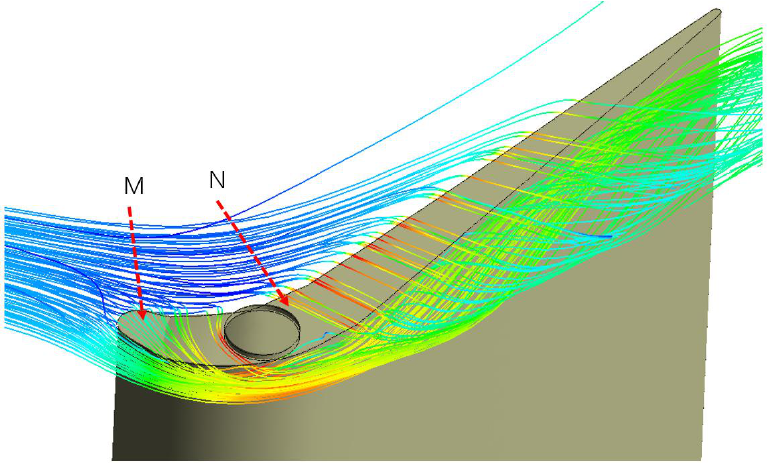
Figure 19. Streamlines near the tip clearance.